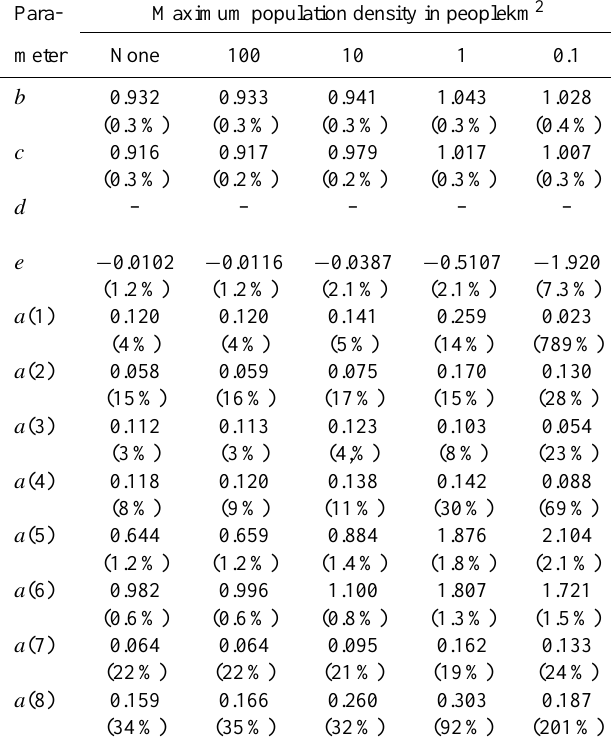
Table A3. Optimal parameters and uncertainties for the optimisations against GFED-SF.